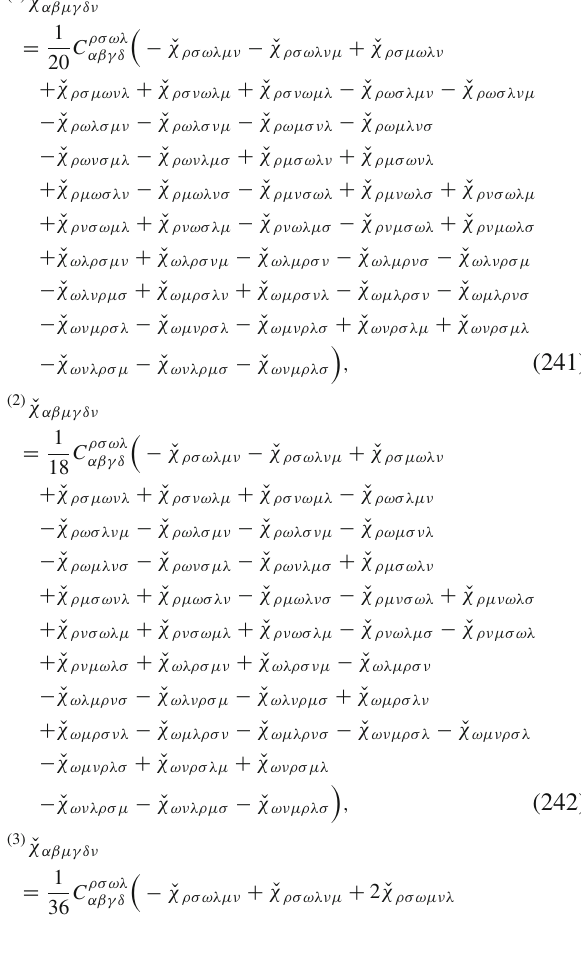
Fig. 2 The resolution of the identity on the 576-dimensional vector space T ˇ χ has a block-diagonal structure in terms of the canonical Young projection operators { I } P : T ˇ χ → T I ˇ χ with I = 1 ,..., 7. We depict these operators by 1 × 1 blocks, with the relative width of f λ I × d I / 576. Provided f λ I > 1, these operators can be further decomposed into non- canonical operators ( I , j ) P : T I ˇ χ → T I ˇ χ with j = 1 ,..., f λ I . We depict this internal ambiguity by inserting f λ I × f λ I smaller blocks the 3rd and 4th index, and so on. In the last lines we switched to the more convenient cycle notation. Note that in our con- ventions the Young symmetrizers are not